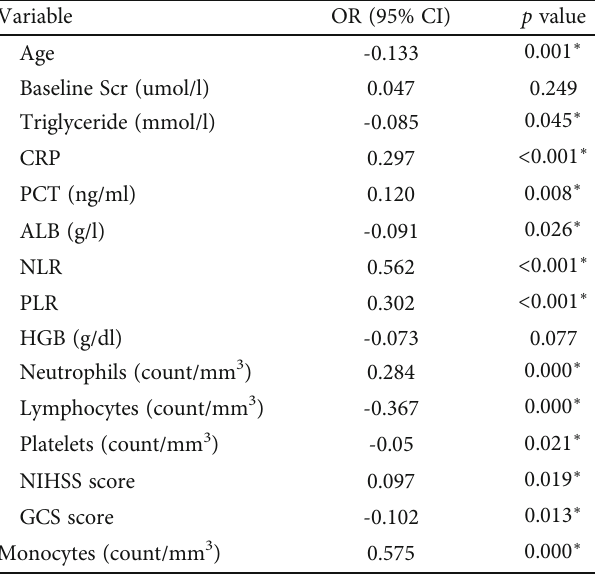
Table 2: The relationship between baseline MLR and other